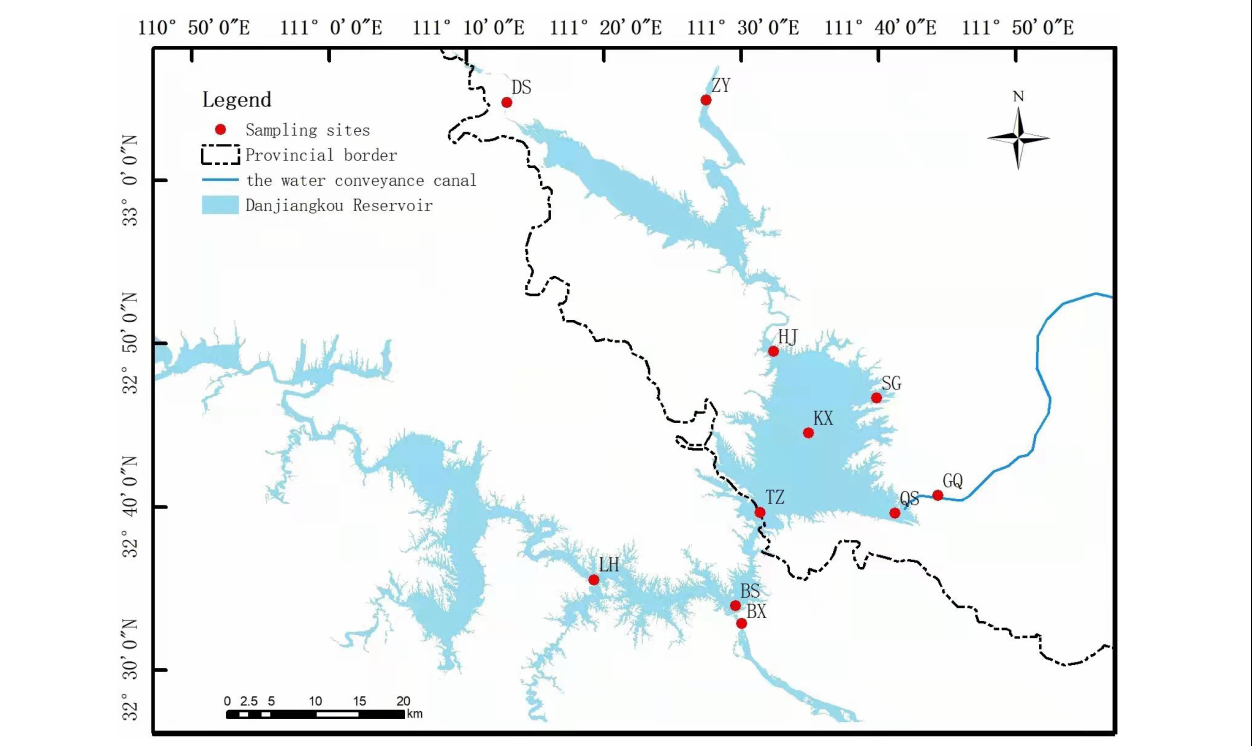
FIGURE 1 | Location of study area and distribution of sampling